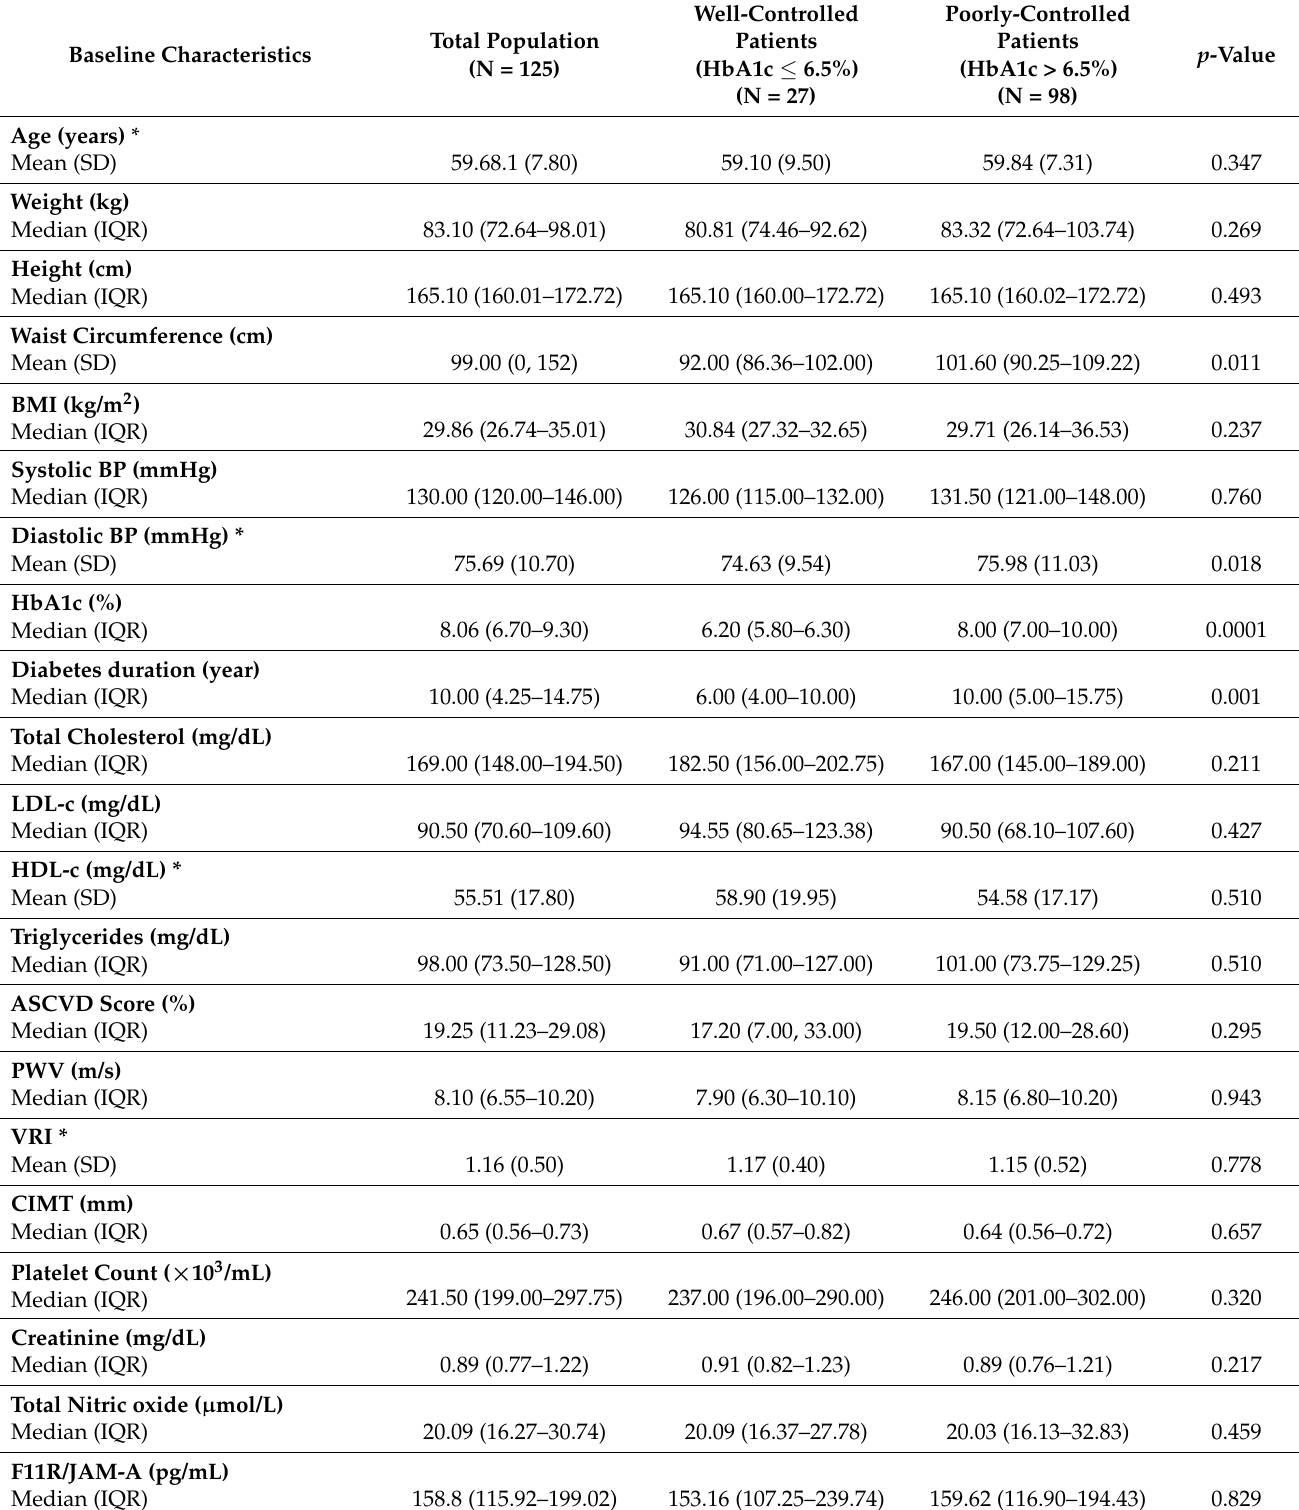
Table 1. Baseline characteristics of the total study population and stratified groups based on HbA1c